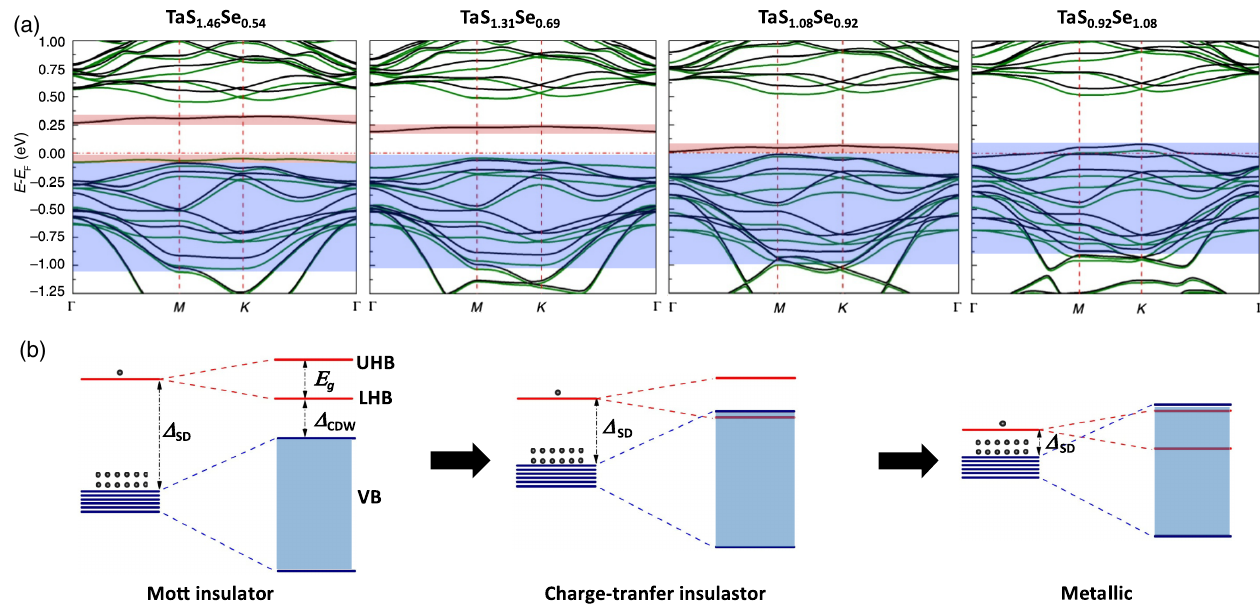
FIG. 6. (a) DFT þ U band structures of Se substituted 1 T-TaS 2 . The meaning of the colors is the same as in Fig. 1(d). (b) Schematic energy level diagrams of the Mott insulating phase, the charge-transfer insulator phase and the metallic